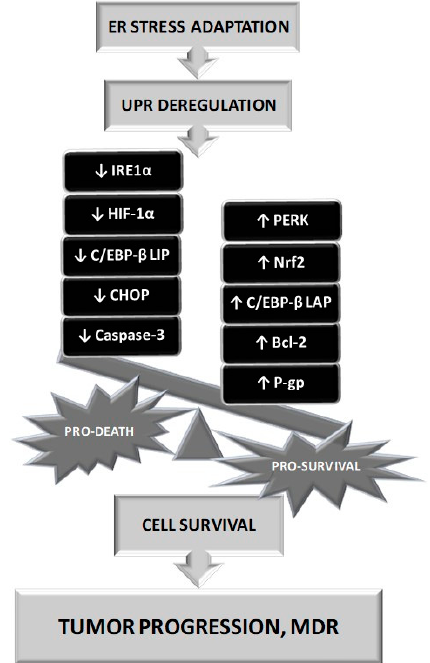
Figure 3. The role of Endoplasmic Reticulum Stress (ERS) in tumour progression and development of multidrug resistance. The adaptation to ERS leads to deregulation of UPR, activation of pro survival pathways, suppression of apoptotic pathways and overexpression of P-glycoprotein (P-gp) in malignant cells.